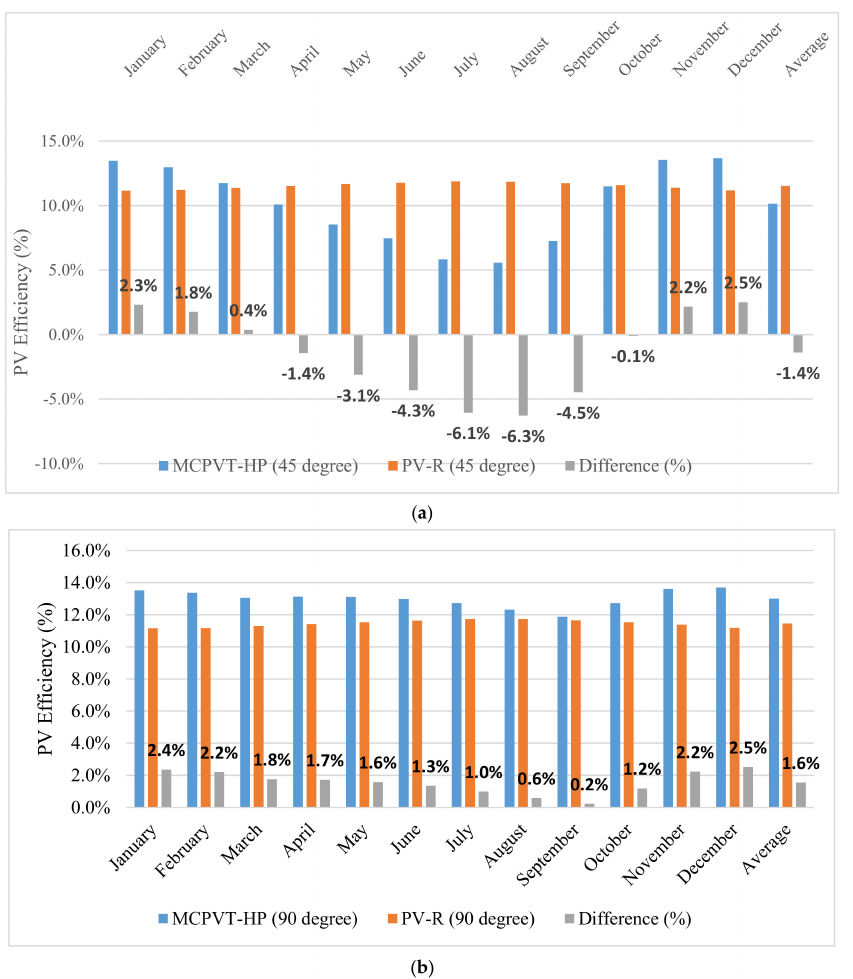
Figure 13. ( a ) PV efficiency comparison between MCPVT and PV-R system with a 45 ◦ tilt angle; ( b ) PV efficiency comparison between MCPVT and PV-R system with a 90 ◦ tilt